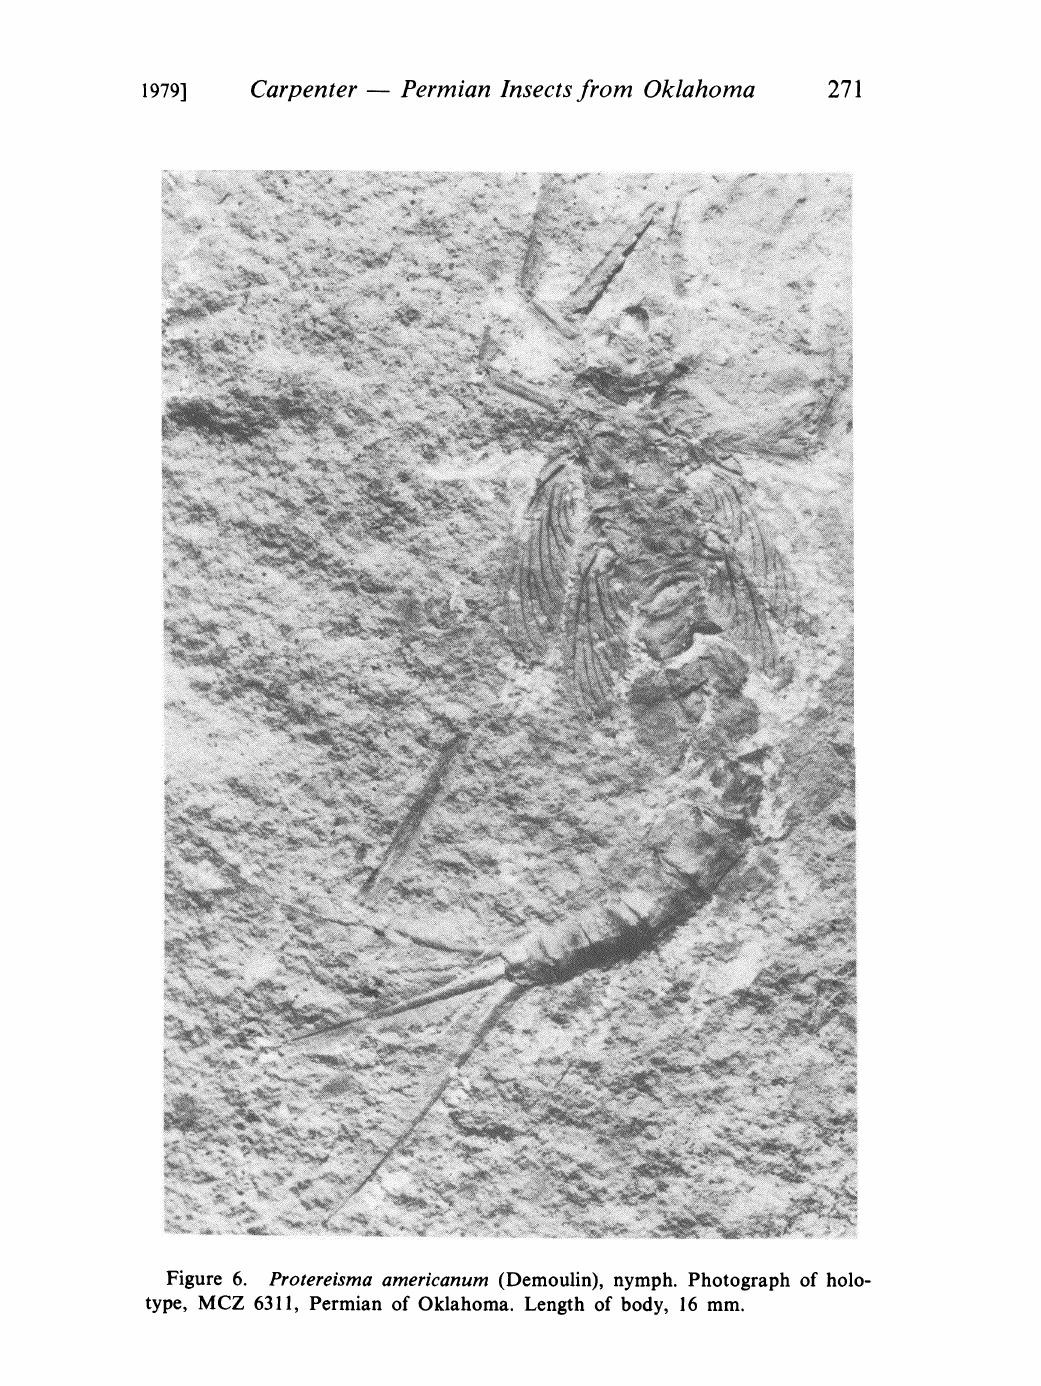
Figure 6. Protereisma americanum (Demoulin), nymph. Photograph of holo- type, MCZ 6311, Permian of Oklahoma. Length of body, 16